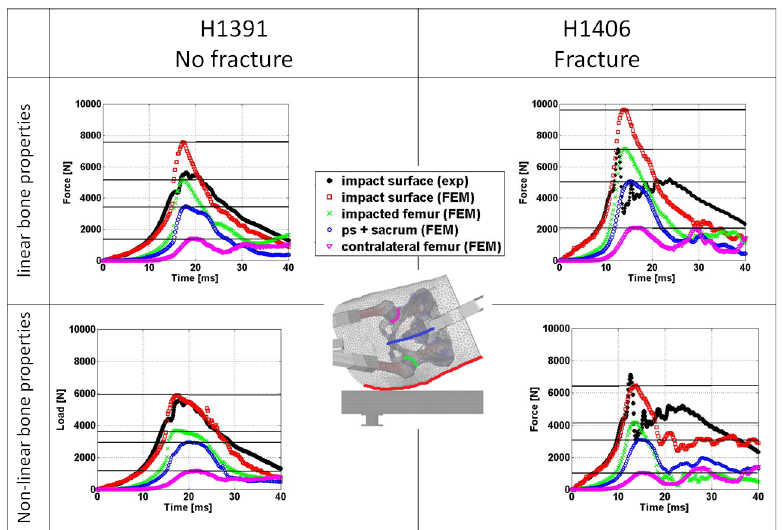
Fig 8. Comparison of internal reaction forces in the hip over time between experimentally and FEM derived results. Linear FEM results are in the top row and non-linear FEM results in the bottom row. Horizontal lines mark the peak forces recorded for the different evaluation sites in the FEM.